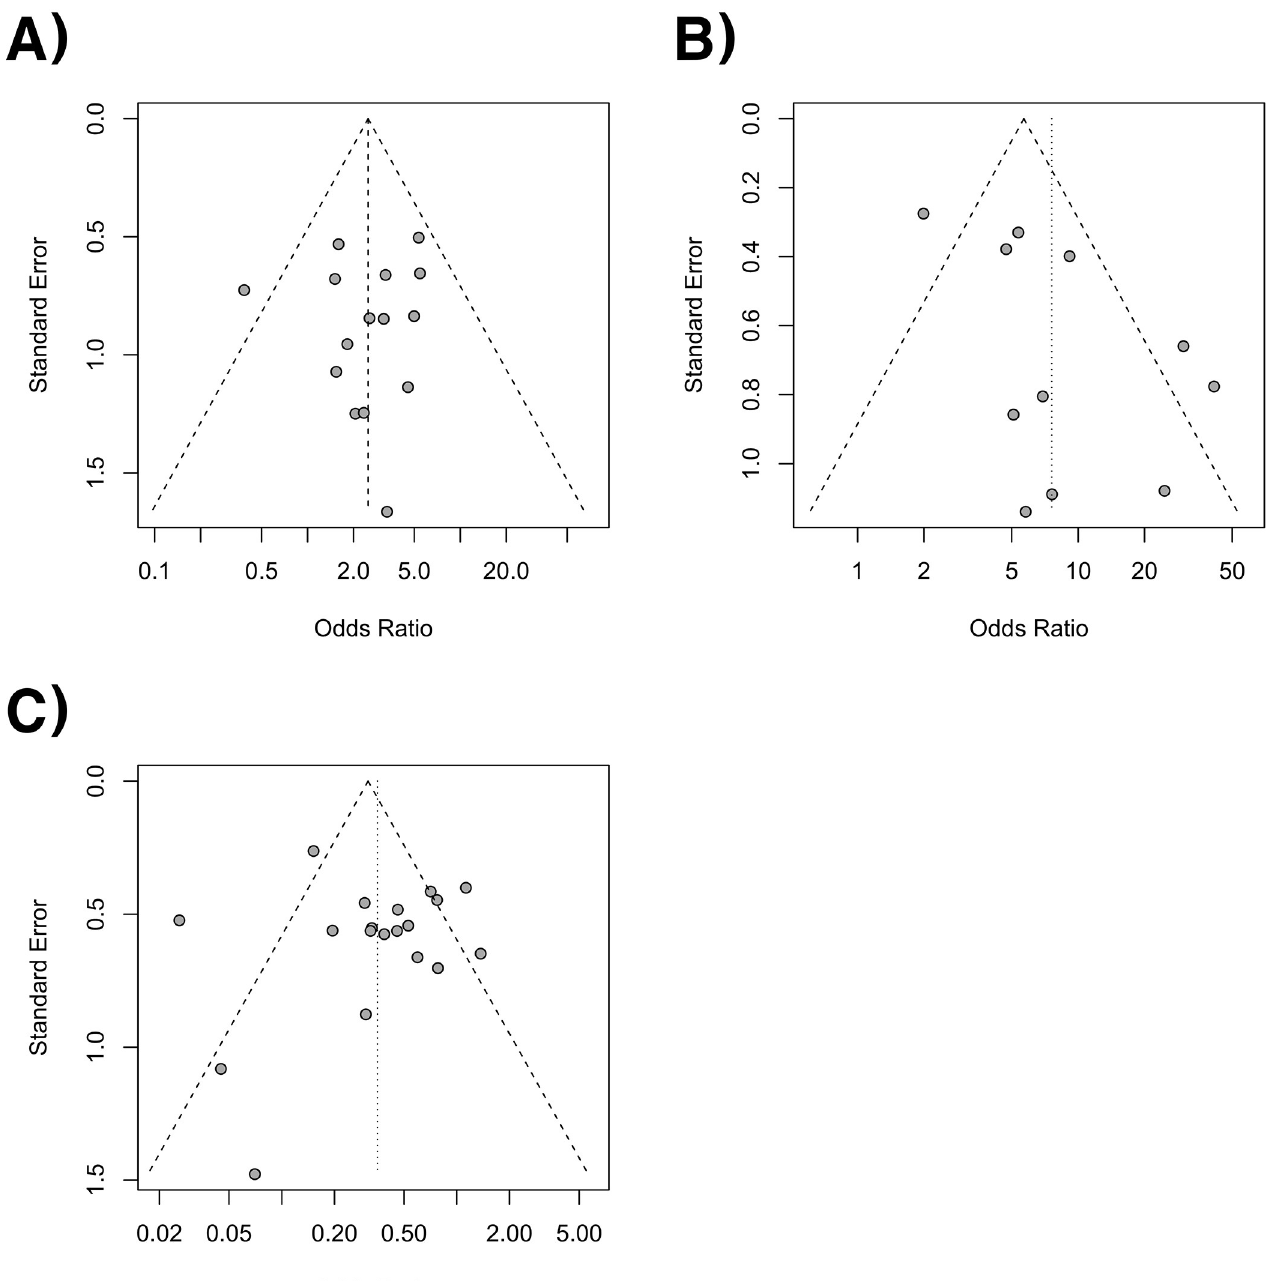
Fig 10. Funnel plots of success rate between RIRS and PCNL (A), SWL and PCNL (B), and RIRS and SWL (C). There were some publication bias in funnel